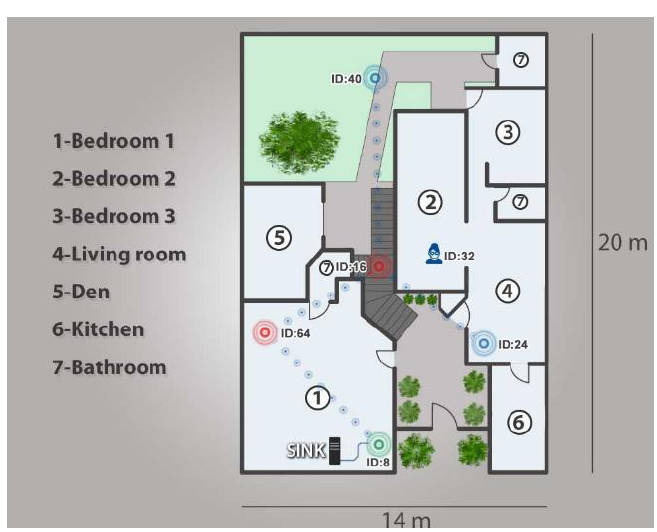
Figure 14. Created network.